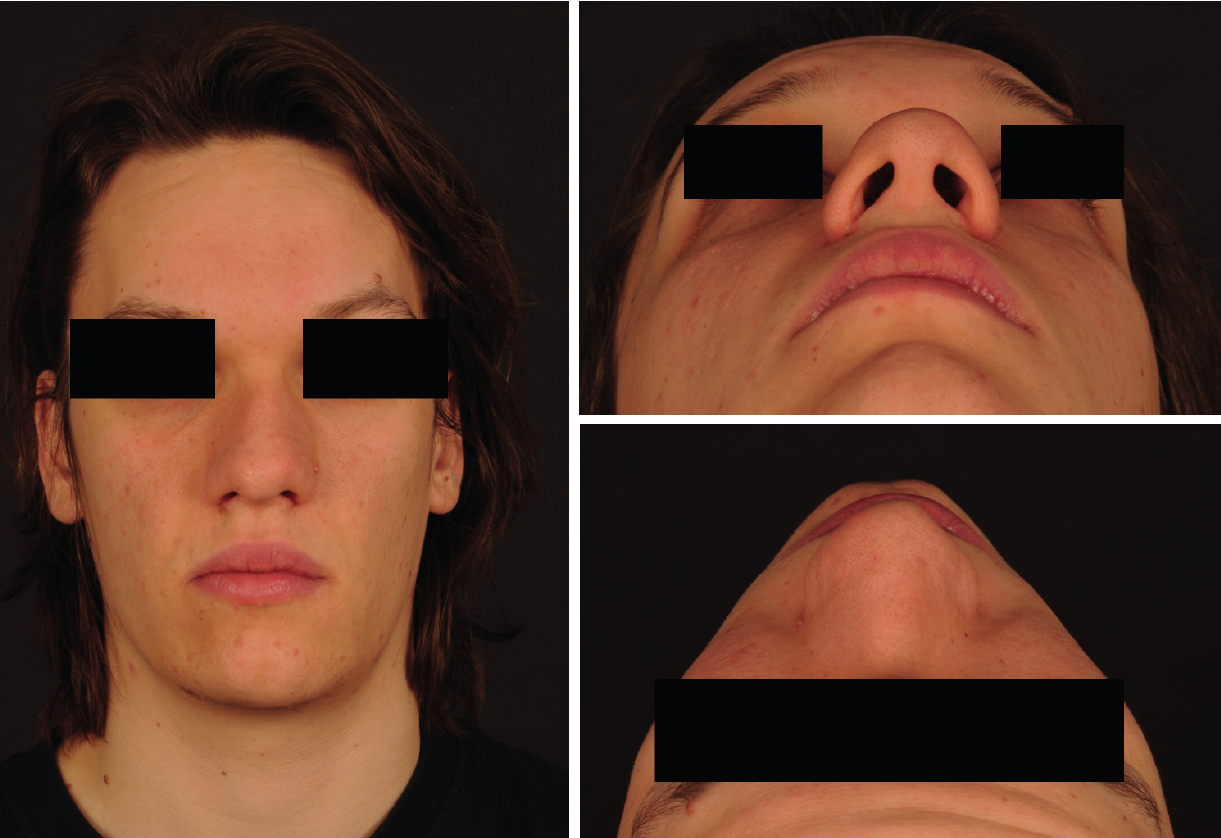
Figure 3. Clinical images taken after treatment with liposomal amphotericin B. Swelling of the left lateral side of the nose has diminished. Minimal asymmetry of the nose is visible.